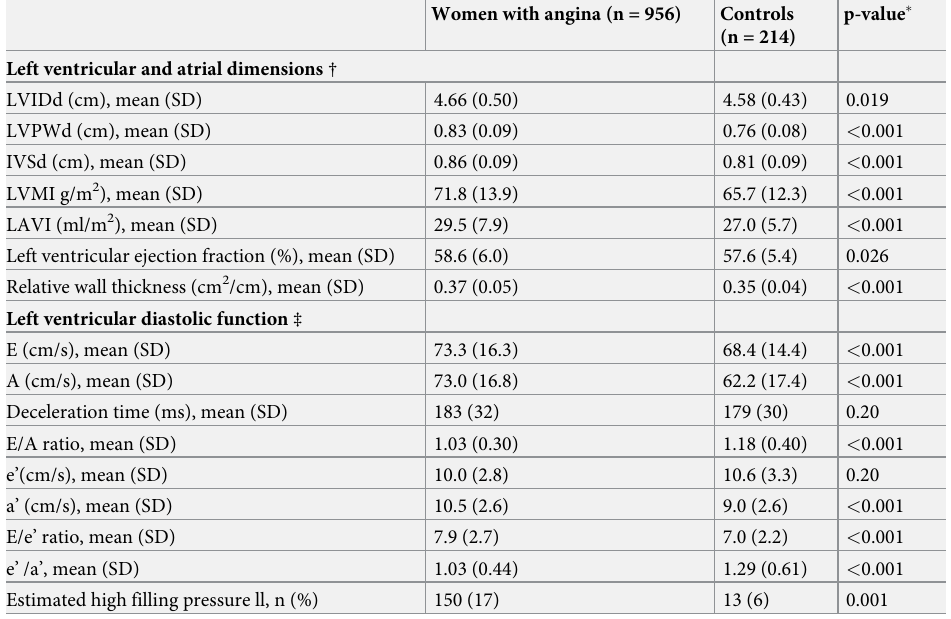
Table 2. Echocardiographic parameters in women with angina and no obstructive coronary artery disease and controls.